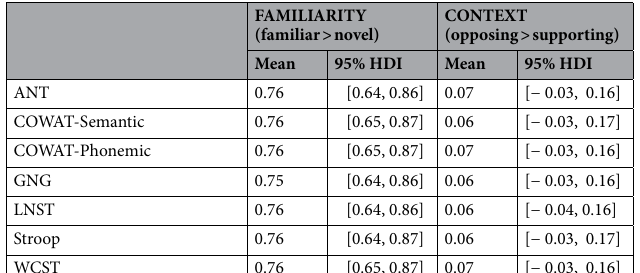
FAMILIARITY (familiar > novel)